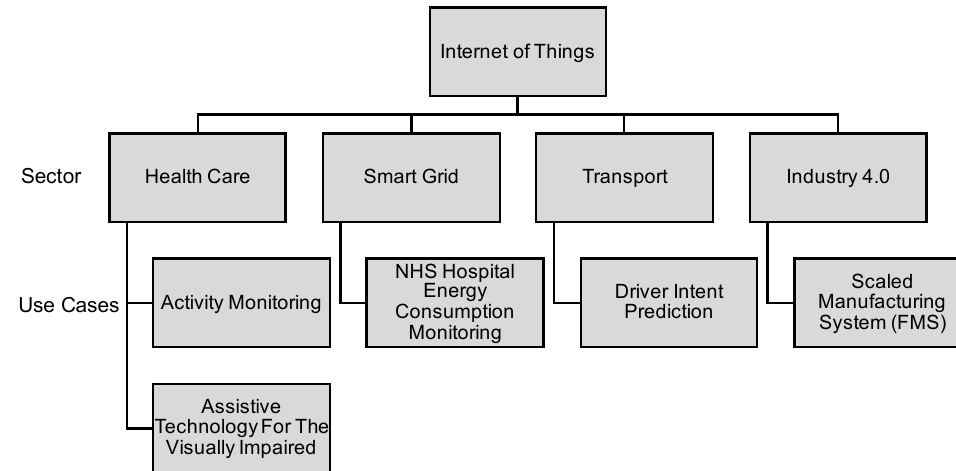
Figure 2. Use cases presented in this paper, showing the sectors and the use